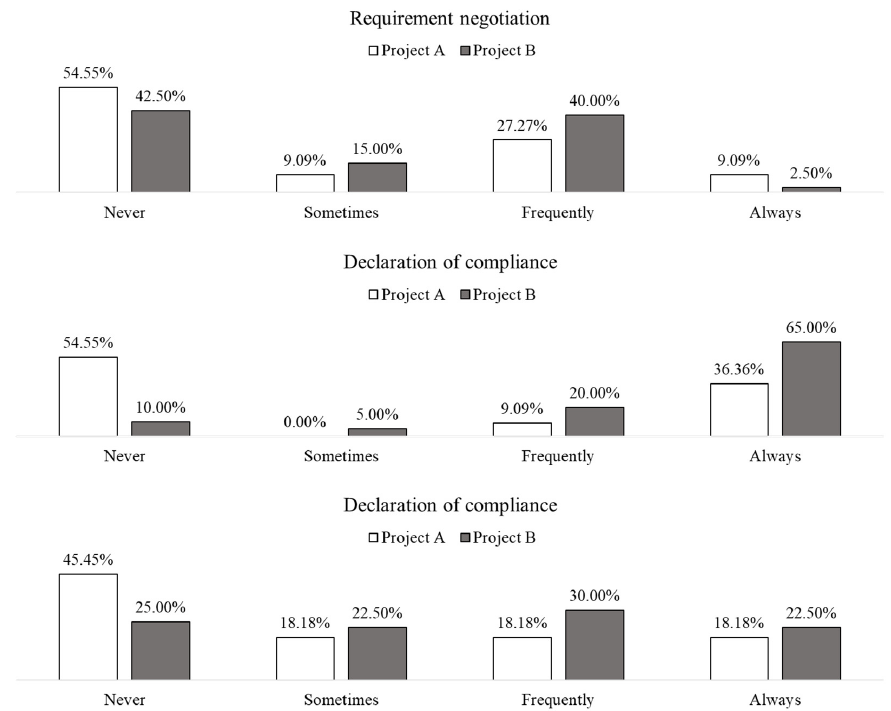
Figure 8. Commitment management metrics according to their interaction frequencies: Project A and project B. project